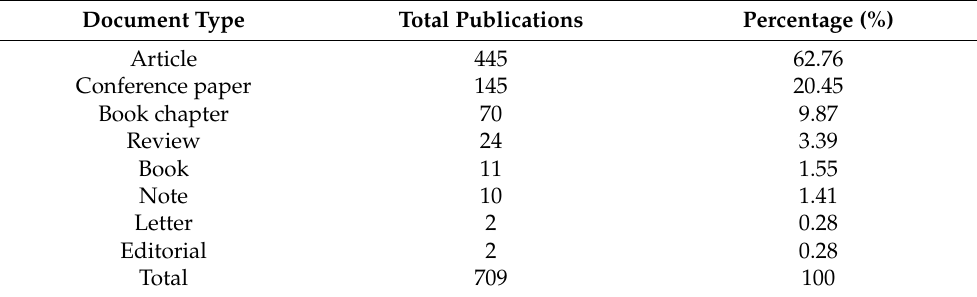
Table 2. Distribution of document types in the retrieved